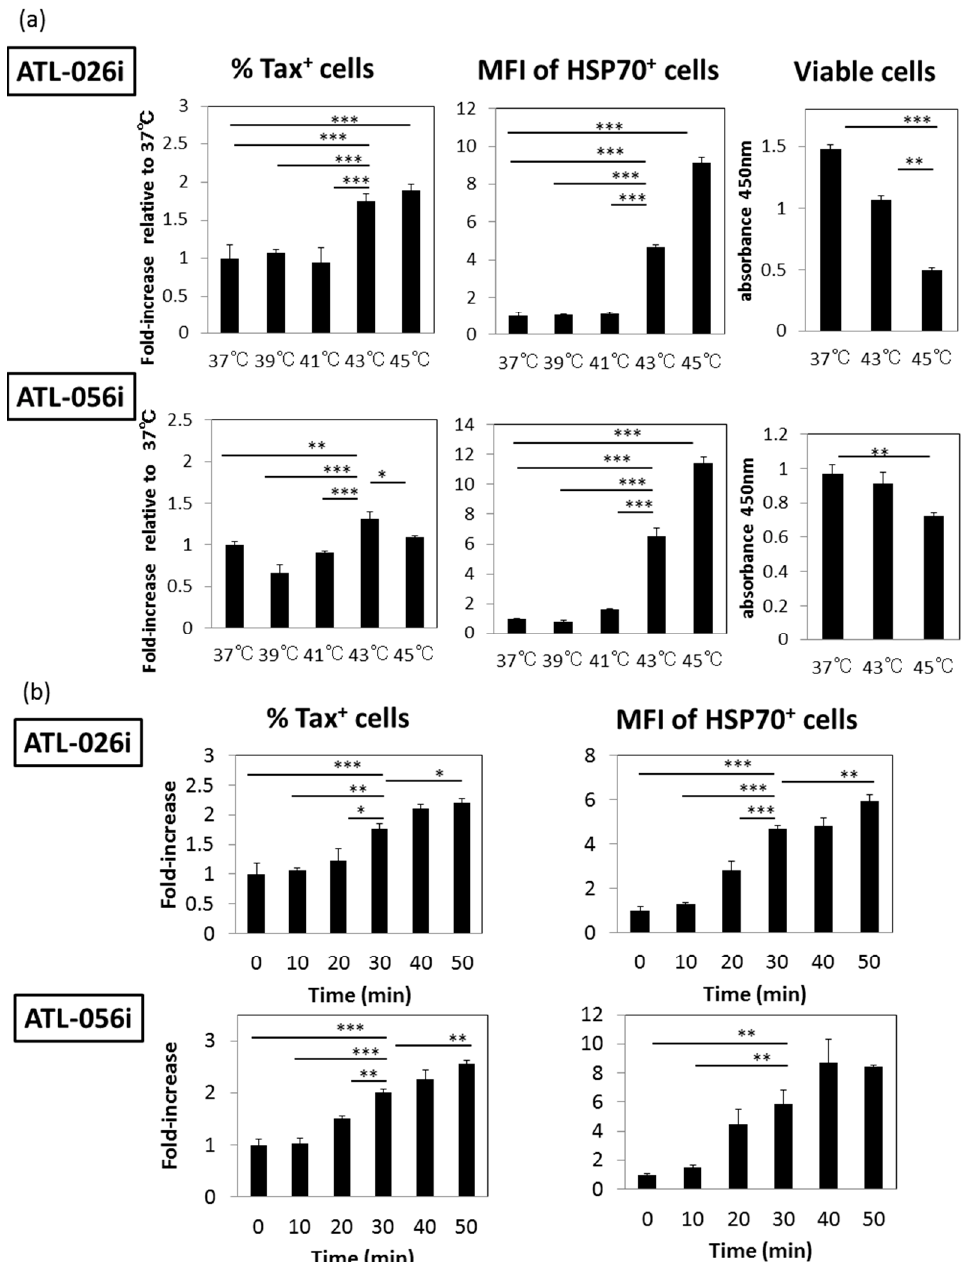
Figure 1. Effects of heat shock (HS) exposure on human T cell leukemia virus type ‐ I (HTLV ‐ I) ‐ infected cell lines derived from acute adult T cell leukemia (ATL) patients: ( a ) Aliquots of ATL ‐ 026i and ATL ‐ 056i cells were incubated at various temperatures for 30 min and cultured for 24 h. The cells were then analyzed for the frequencies of trans ‐ activator (Tax) + cells (left bar graphs) by flow cytometry (FCM) and the relative density (Mean Fluorescent Intensity, MFI) of heat shock protein 70 (HSP70) expression (middle bar graphs) and for cell viability using the CCK ‐ 8 cell counting kit (right bar graphs). ( b ) The kinetics of the up ‐ regulation of Tax and HSP70 expression by the same two cell lines following exposure to 43 °C for various times is shown. The values denote the means ± SD. * p <0.05, ** p <0.01, *** p <0.001.